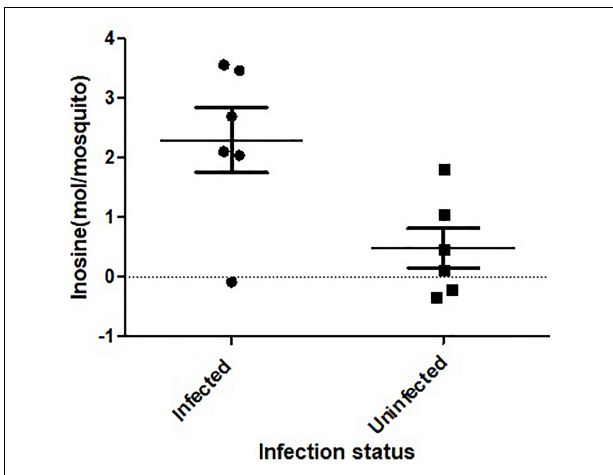
FIGURE 3 | Inosine quantification in ZIKV-infected Ae. albopictus . A fluorometric assay was utilized to compare inosine levels in ZIKV infected (ZIKV- positive legs) and non-infected Ae. albopictus individuals. The individuals were offered 8.3 log 10 PFU/ml ZIKV HND strain blood meal or uninfected blood meal. At 7 dpi, the legs were dissected and screened for infection and the whole body of individual mosquito was used to determine the inosine levels. The background was corrected by subtracting the blank fluorescent reading value from all readings and the standard curve generated from the corrected values of the inosine standards. The sample blank value was subtracted from the sample readings and the amount of inosine present was determined from the standard curve using the corrected measurements. The X axis represents the infection status of the mosquitoes while the Y axis represents the concentration (moles) per